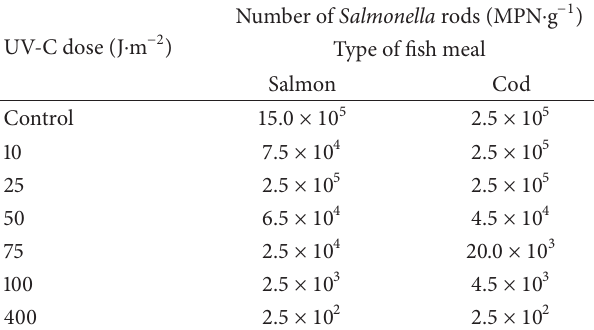
Table 1: Exposition times of inoculated samples of fish meal needed to obtain the intended UV-C dose in case of a distance of 1m between UV source and probe.